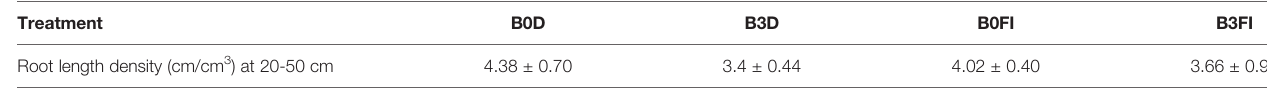
TABLE 2 | Root length density for B0 and B3 in the 20-50 cm layer in 2015 determined by the Newman method. Treatment